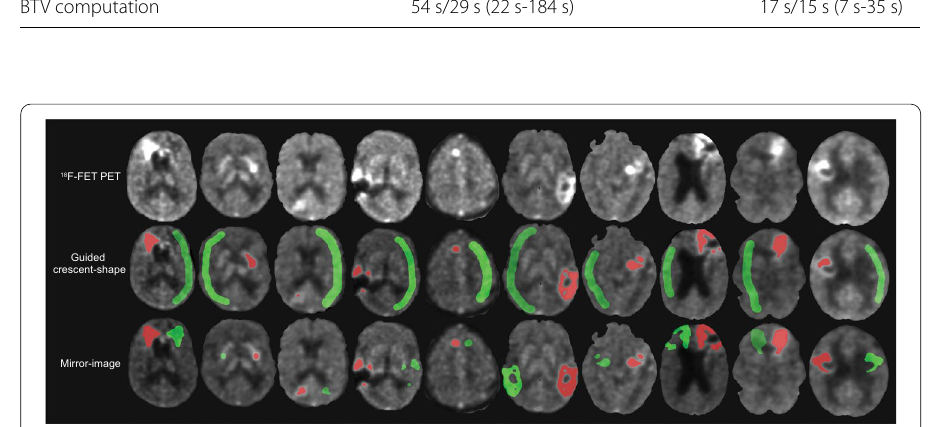
Fig. 2 Representative images and segmentations obtained with the two background assessment methods. Top–bottom: 18 F-FET PET images of ten GBM patients; 18 F-FET TBR images with overlays of BTV (red) and CTRL VOI (green) obtained with the gCS method; 18 F-FET TBR images with overlays of BTV (red) and CTRL VOI (green) obtained with the MI method. BTV biological tumour volume; CTRL contralateral background = = 18 F-Fluoroethyl- l -tyrosine; TBR reference region; FET tumour-to-brain ratio; VOI volume of = = =